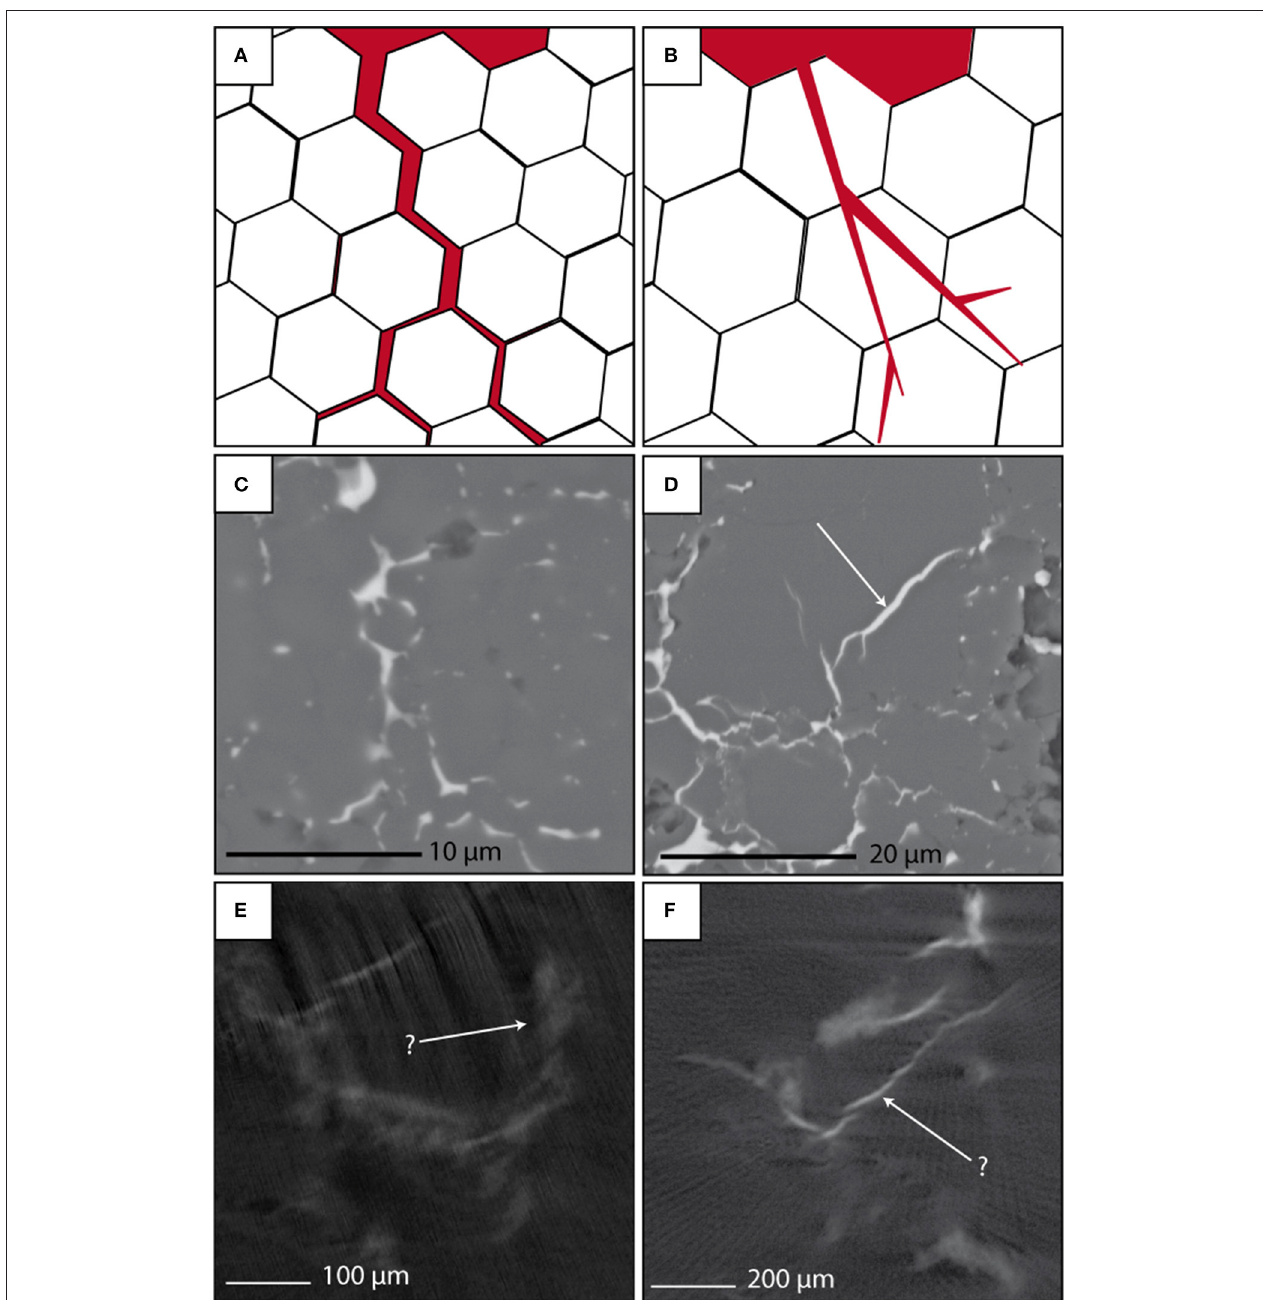
FIGURE 12 | End-member mechanisms for migration of metallic melt in polycrystalline material under extreme P-T conditions. (A) Formation of melt channels (red) by grain boundary wetting (grains pried apart; dominant influence of grain boundaries). (B) Melt migration by fracture propagation (grains fractured, with little influence of grain boundaries). Panels (C,D) show formation of melt channels/sheets by both processes in the system FeS melt-olivine (Berg et al., 2017) in deformation experiments at extreme P-T. In these experiments, fracturing becomes dominant at higher strain rates, while grain boundary migration dominates at low strain rates, although fractures in the olivine matrix are typically a few 10s of µ m in length at most and cut across a small number of olivine grains, as opposed to the (typically) extensive sheets noted in au + h-BN experiments. Panels (E,F) show comparable features in the present tomographic data set (Au melt in h-BN) observed in tomographic scans. More diffuse, poorly defined, regions of increased attenuation are interpreted as extensive wetting of grain boundaries, while hydraulic fracturing produces well-defined, planar features.